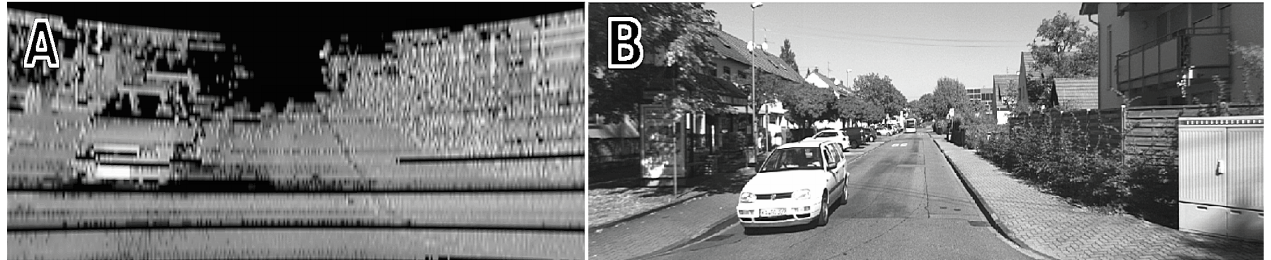
Figure 3. Visual comparison of an image generated from Velodyne HDL-64E intensity data ( A ) and the corresponding grayscale camera image ( B ) from the KITTI